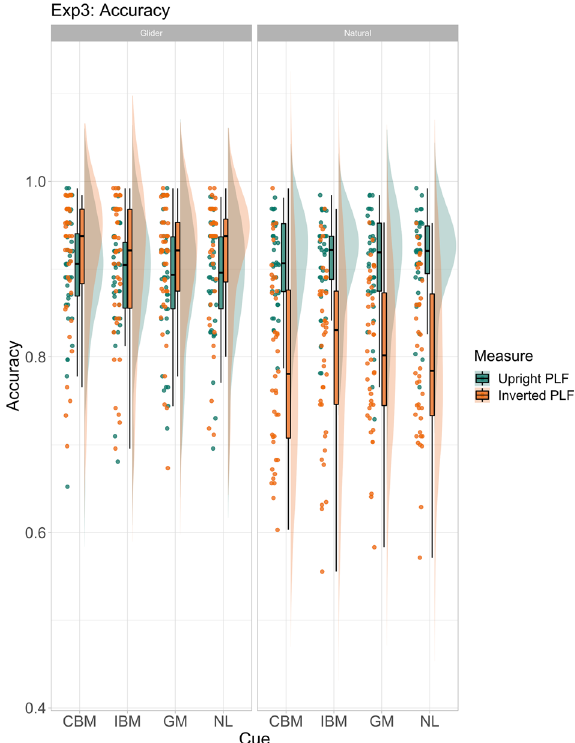
Figure 6. Accuracy (raw data) for glider and natural PLF motion conditions, for upright and inverted PLF orientation conditions for Experiment 3. Cue names are as follows: CBM congruent biological motion, IBM incongruent biological motion, GM general motion, NL no